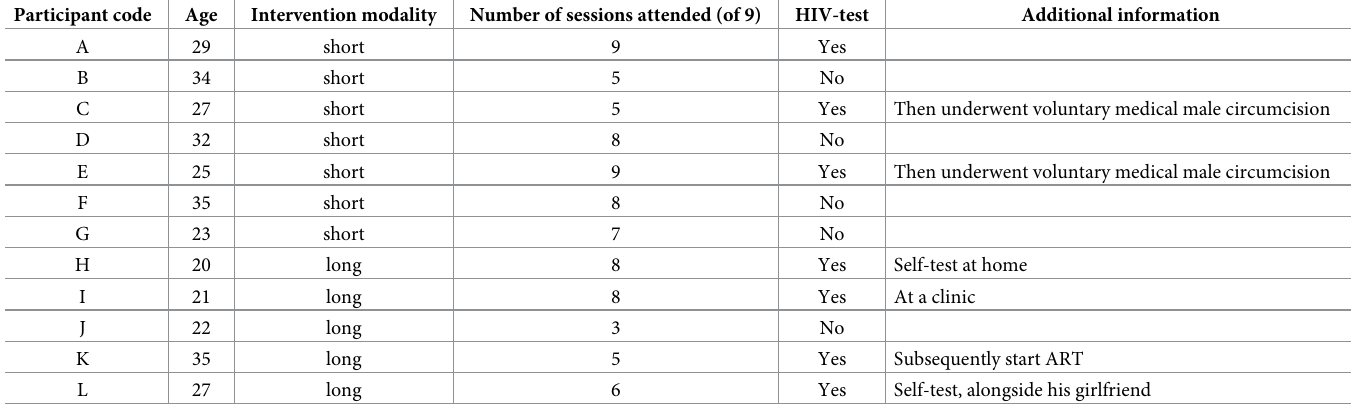
Table 3. In-depth interviewees basic